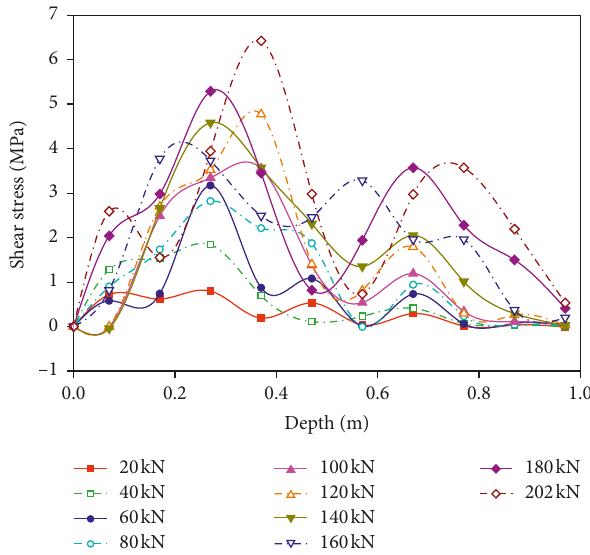
Figure 12: Single load shear stress curves obtained along the length of samples under strong constraint